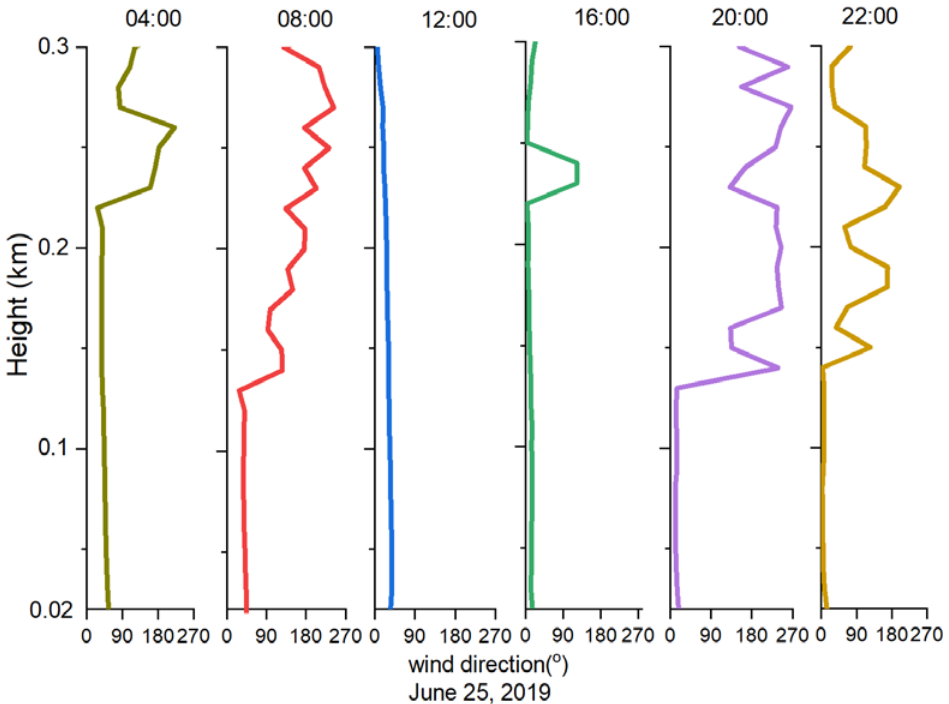
Figure 10. Wind direction profiles measured from sodar on 25 June 2019.